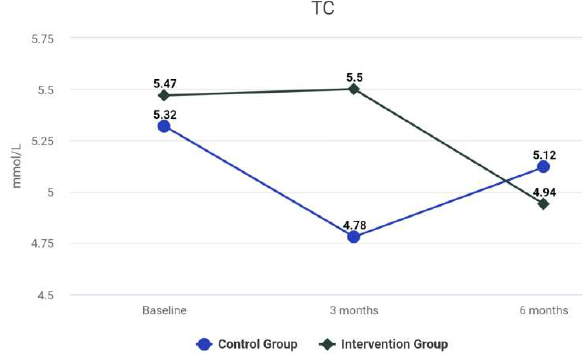
Figure 5. Results of TC at baseline and during follow-up.